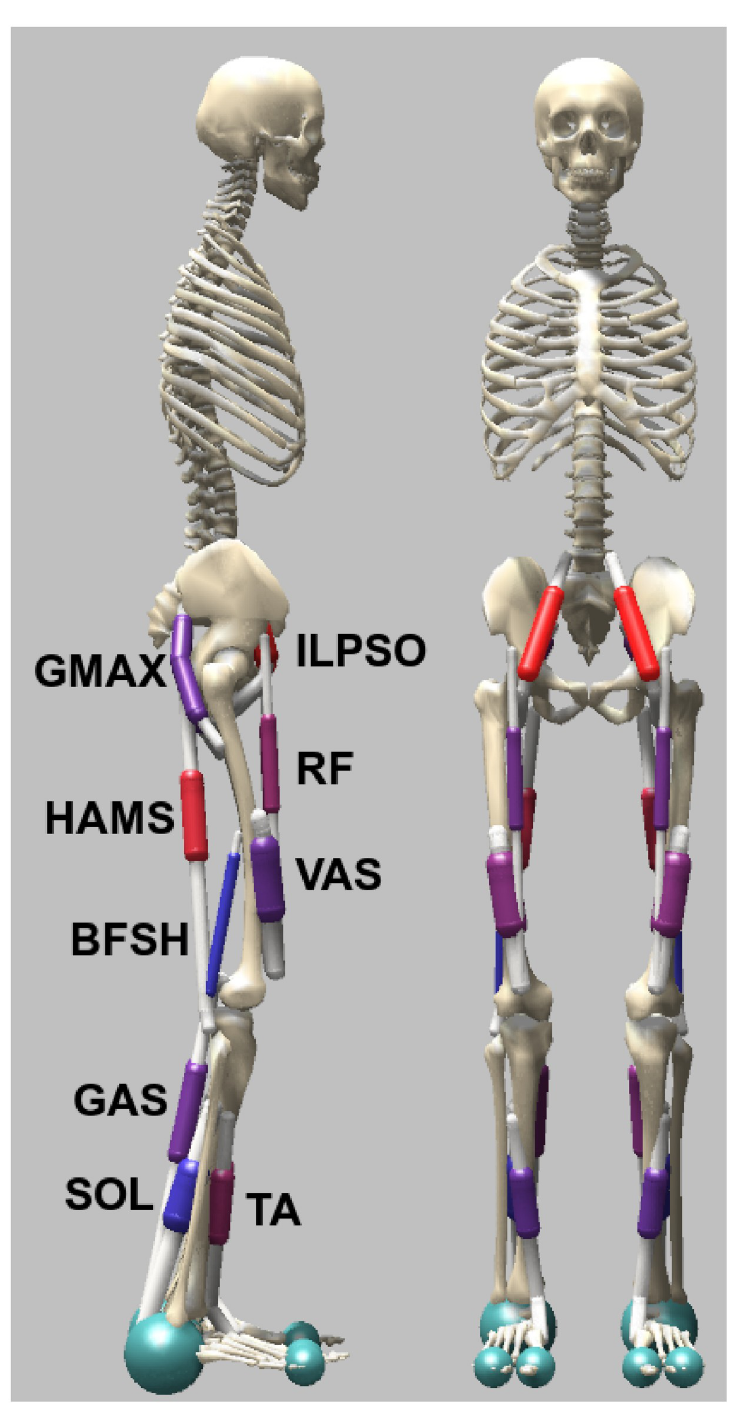
Fig 1. Musculoskeletal model used to study human locomotion. The model is constrained in the sagittal plane and has 9 DoFs: hip and knee flexion/extension, ankle plantar/dorsal flexion for each leg, and a 3-DoFs planar joint between the pelvis and the ground. The movements are generated by the activation of 9 muscles per leg: gluteus maximus (GMAX), biarticular hamstrings (HAMS), iliopsoas (ILPSO), rectus femoris (RF), vasti (VAS), biceps femoris short head (BFSH), gastrocnemius medialis (GAS), soleus (SOL), and tibialis anterior (TA).